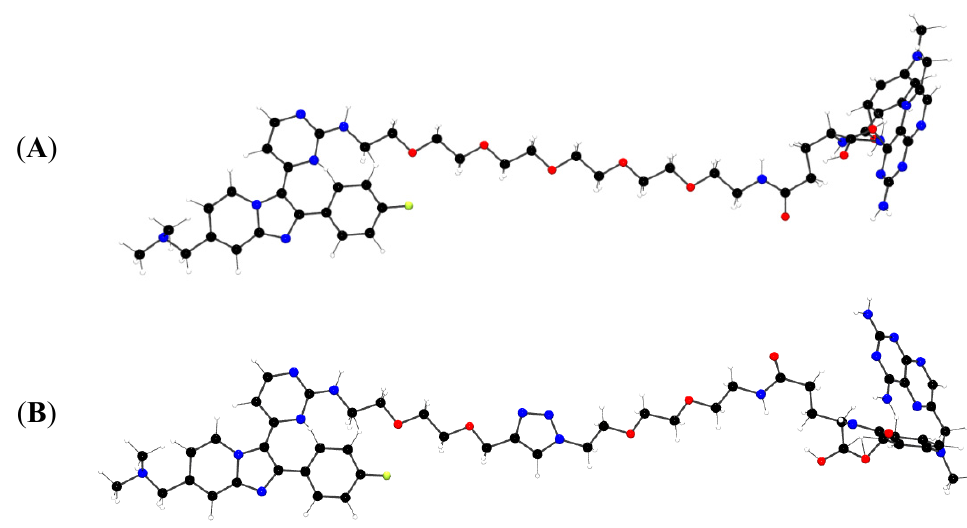
Figure 3. Examples of predicted 3D conformations of ( A ) MTX-Cmpd2.1 and ( B ) MTX-Cmpd2.2